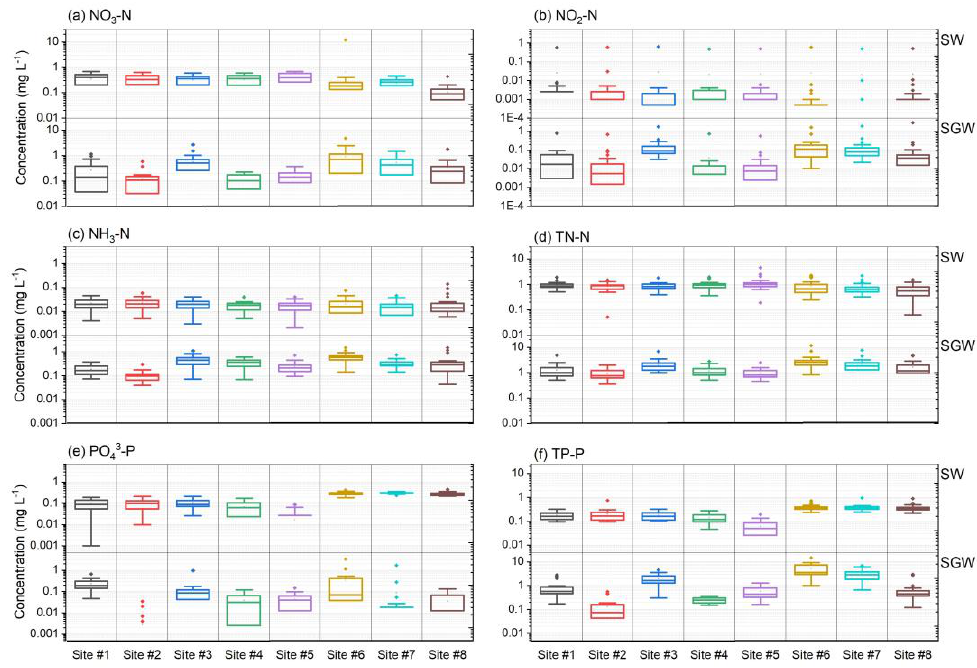
Figure 2. Box and whisker plots of stream water (SW) and shallow groundwater (SGW) nutrient (i.e., NO3 − N, NO2 − N, NH3 − N, TN − N, PO43 − P, and TP − P) concentrations (mg L − 1 ) during the study period (January 2020 − December 2021) for eight monitoring sites in Moore’s Run Watershed, Wardensville, WV, USA; box delineates 25th and 75th percentiles; line denotes median; open circle shows mean; whiskers delineate the range (i.e., 1.5 times the interquartile range); the filled circle indicates potential outliers.